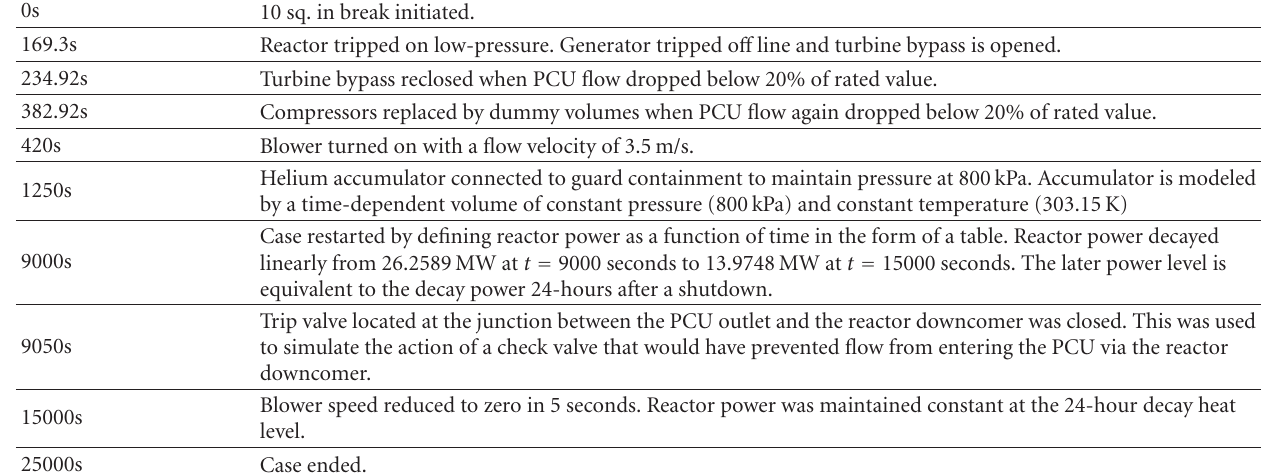
Table 5: Timing of significant events for case